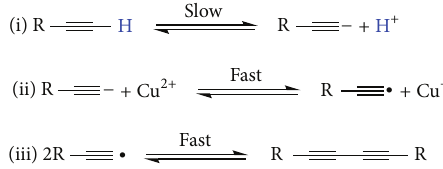
Scheme2:Cu(OAc) 2 -mediatedoxidativehomocouplingofterminal alkynes, as proposed by Salkind and